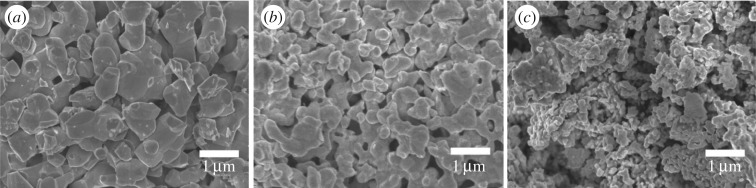
SEM images of (a) CoP, (b) Co0.5Mo0.5P and (c) MoP crystals taken at a magnification of 100 000x.